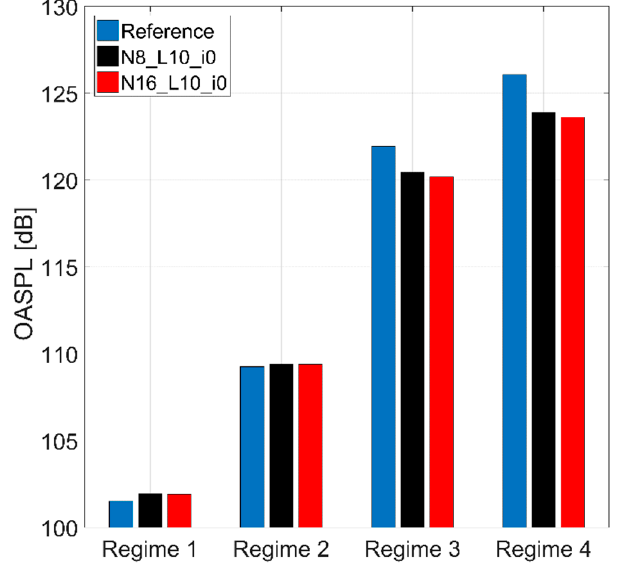
Figure 5. Averaged OASPL variation depending on the tested regime and nozzle configuration.